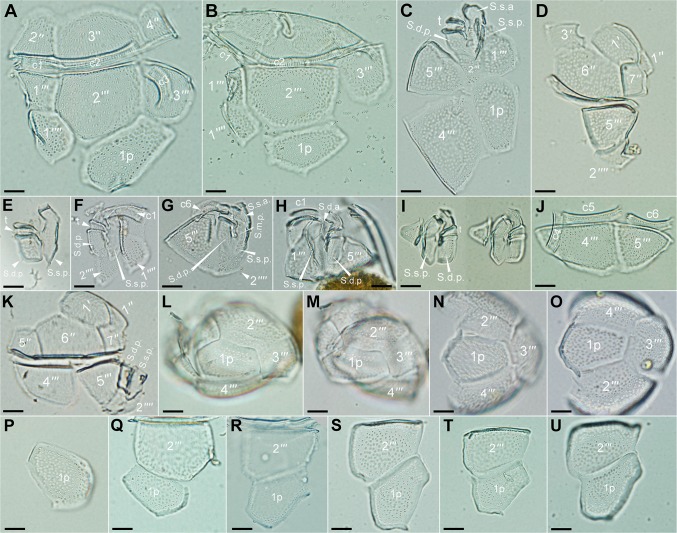
Light micrographs of dissected hypothecal, sulcal and cingular plates of Fukuyoa paulensis gen. et sp. nov. (A-D) Hypothecal plates.(E-I) Sulcal plates. The tiny sulcal median anterior (S.m.a.) plate that was not discernible. (J-K) Postcingular and cingular plates. (L-P) Antapical view of the cells. (P-U) Detail of the first posterior intercalary plate (1p). Scale bar 10 μm.